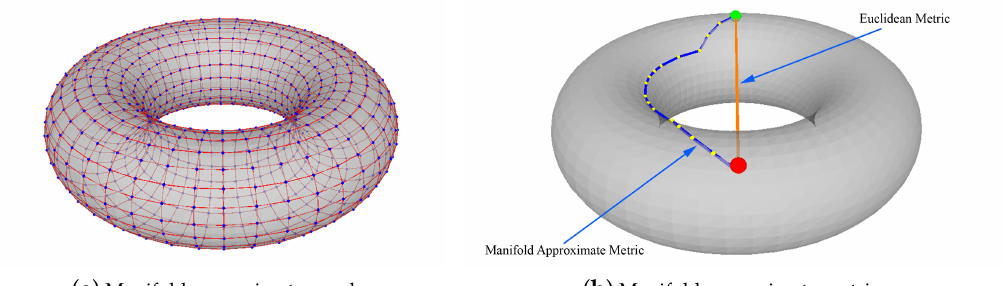
Figure 2. The torus is a two-dimensional manifold in three dimensions. The blue points in ( a ) are the samples that are uniformly sampled on the torus surface. Each point is connected to the five nearest points (red line), thus forming an approximate graph of the manifold. In ( b ), the green and red points are the points needed to perform metric calculation. The blue line is the shortest path that the Dijkstra algorithm searches on the graph, and the yellow points is the way-points on the shortest path. The length of the path can be used as an approximate metric between the two points on torus surface. The length of the orange line is the Euclidean metric between these two